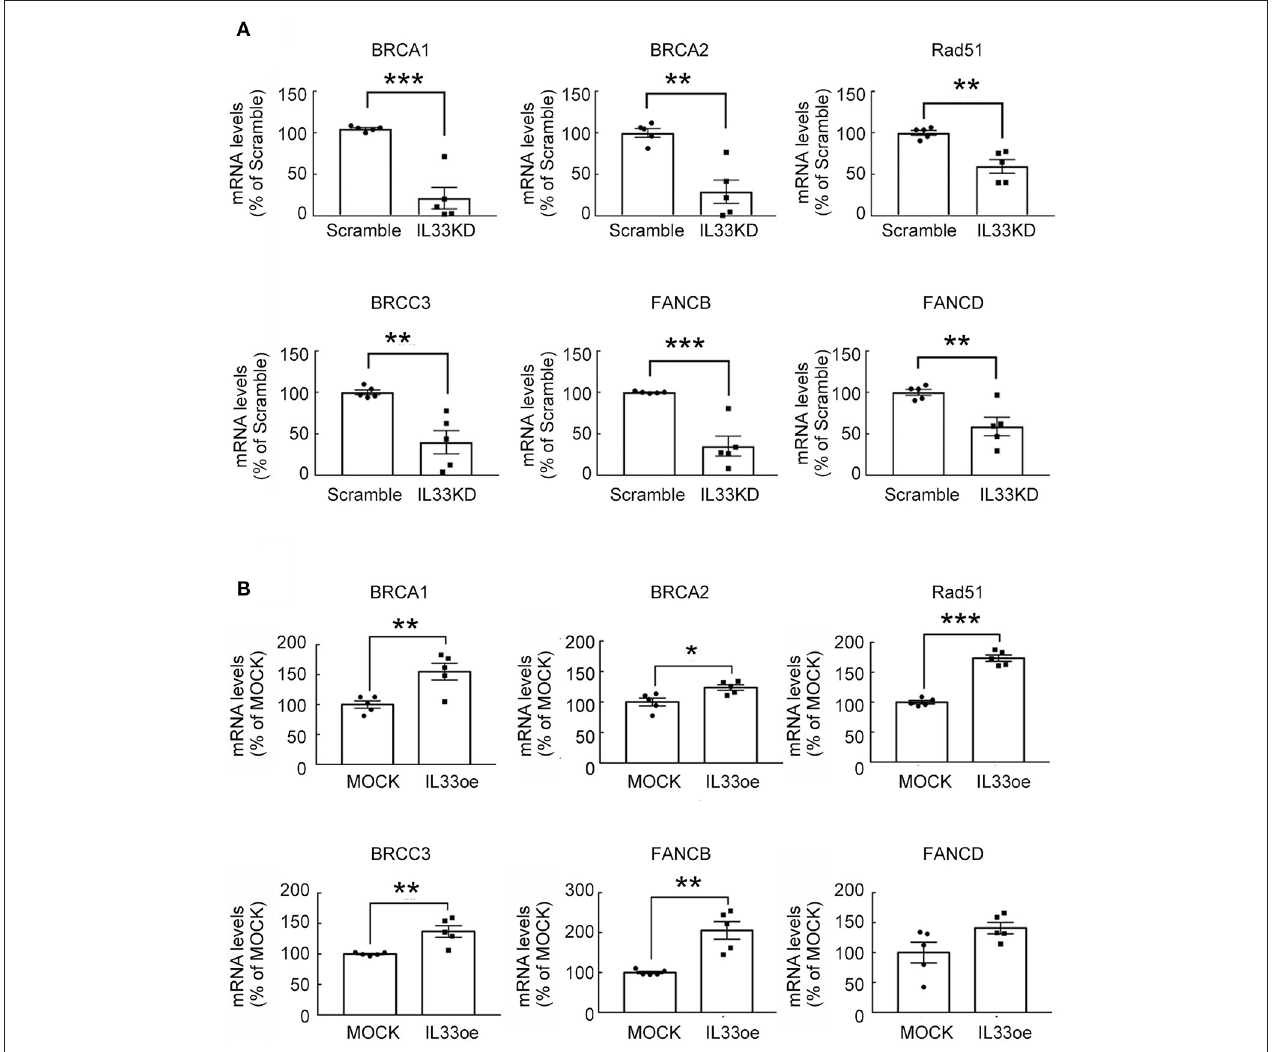
FIGURE 4 | IL-33 regulates DNA repair genes in U251MG cells. RNA samples isolated from Scramble- and IL33KD-U251MG cells (A) , as well as MOCK- and IL33oe-U251MG cells (B) , were subjected to qPCR analysis for the measurement of DNA repair genes (i.e., BRCA1, BRCA2, Rad51, BRCC3, FANCB, and FANCD). The results are present as mean ± SEM from the five cell passages ( n = 5). * P < 0.05, ** P < 0.01, *** P < 0.001 vs. Scramble (A) or MOCK (B) . IL-33, interleukin-33.